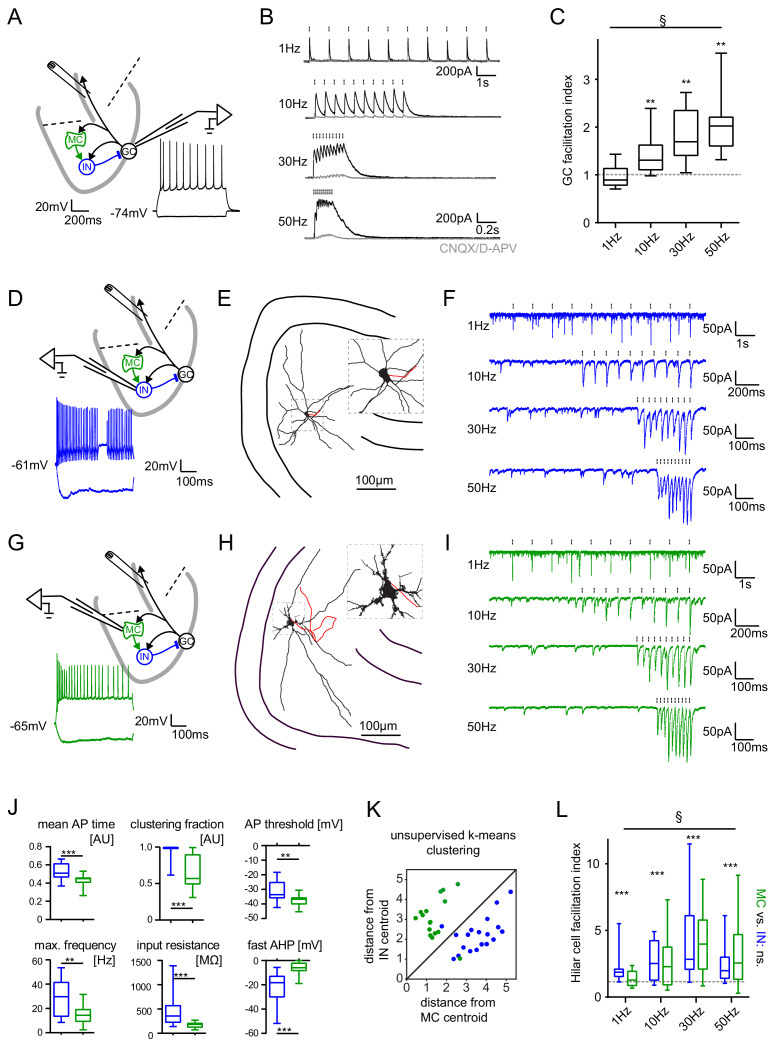
Short-term dynamics in the feedback inhibitory microcircuit.Trains of ten antidromic electrical stimulations at 1, 10, 30 or 50 Hz were applied to elicit disynaptic feedback inhibition or excitation of hilar cells (electrical stimulation artifacts were removed in all traces). (A, D, G) Schematic illustration of the experimental setup and example traces of voltage responses to positive and negative current injections of GC and hilar cells (dashed lines indicate cuts to sever CA3 backprojections). (B) Exemplary GC feedback IPSCs before (black) and after (grey) glutamatergic block (n = 7). (C) Facilitation indices (mean of the last three IPSCs normalized to the first; n = 10 cells). (D-L) Hilar cells were manually classified into putative interneurons (blue) or mossy cells (green) based on their morpho-functional properties. (E) Reconstruction of biocytin filled hilar interneuron (axon in red). (F) Interneuron EPSCs in response to stimulation trains. (H) Reconstruction of biocytin filled mossy cell (axon in red). (I) Mossy cell EPSCs in response to stimulation trains. (J) Quantification of intrinsic properties of hilar cells (see Materials and methods). (K) k-means clustering based on intrinsic properties of hilar cells (coloring according to manual classification). (L) Facilitation indices of classified hilar cells. (§ indicates significance in one-way RM ANOVA, * show significance in Bonferroni corrected Wilcoxon signed rank tests for deviation from 1).